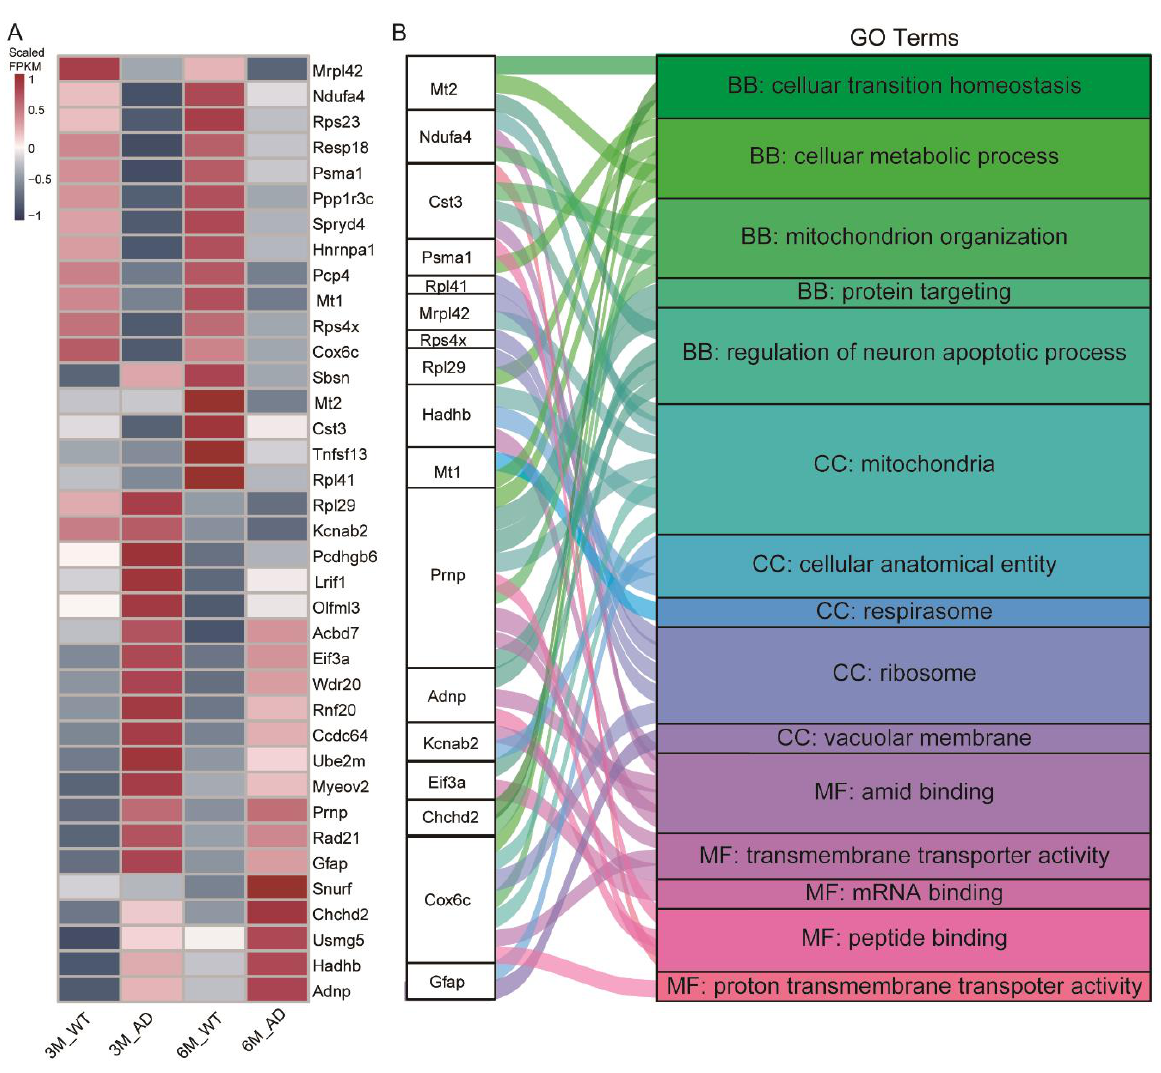
Figure 3. Local transcript changes associated with the mitochondrial metabolic signaling network. ( A ) Heatmap showing the differentially expressed genes (DEGs) that overlapped in both 3- and 6-month-old AD mice. Gene names of each group are listed. ( B ) Color spectrum showing the Gene Ontology (GO) terms associated with 17 DEGs of the top 10 enriched GO terms. The results are presented as a Sankey diagram, and the different colors indicate the relative GO terms respectively ( p < 0.05, fold-change ≥ 1.25 or ≤ 0.8). The DEGs of samples from 6-month-old mice were ranked according to log2 (fold change), and the top 17 genes were selected. All analyses were performed in a pooled sample from an average of n ≥ 3